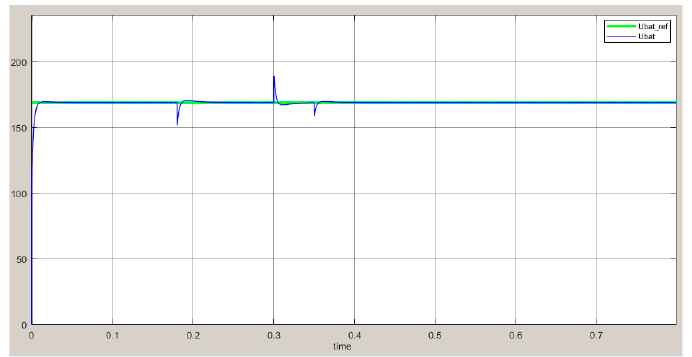
Figure 7. Output results for variable input voltage at operating state 5.